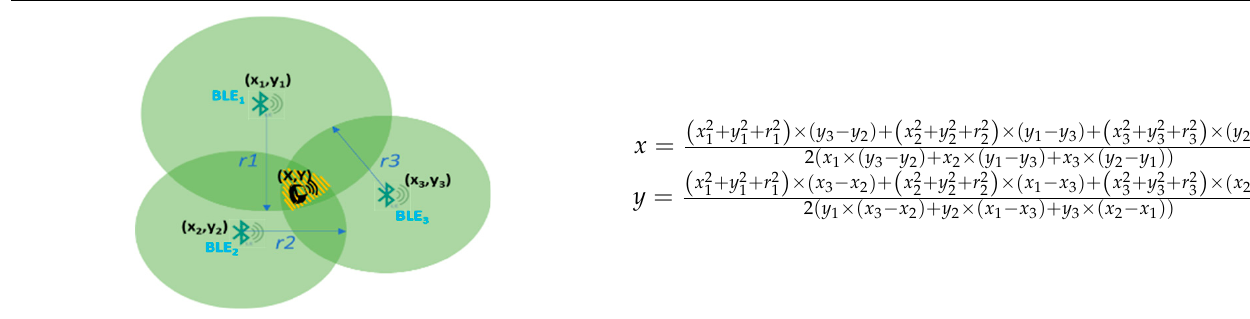
Figure 4. Variation of assessed distance from the Beacon compared with the actual one. For daily activity detection minimum three devices are deployed in each room and trilateration techniques are used [47,48] which determine the point of intersection of the three circles generated by the Bluetooth Beacons emitting signals in the room. Table 2 shows the point of intersection ( x , y ) representing the older adult location inside the room. The central points ( x 1 , y 1 ) , ( x 2 , y 2 ) , ( x 3 , y 3 ) representing the coordinates of the Beacons deployed in the room and circulus radius of the emitted signals ( r 1 , r 2 , r 3 ) are already known. To ease the calculation and activity identification processes the Beacons are installed in the corners of the room or attached to the objects relevant for the activity carried out (e.g., TV, bed, fridge, book, etc.). Table 2. Trilateration technique used for determining the location in a room (adapted from [47,48]).